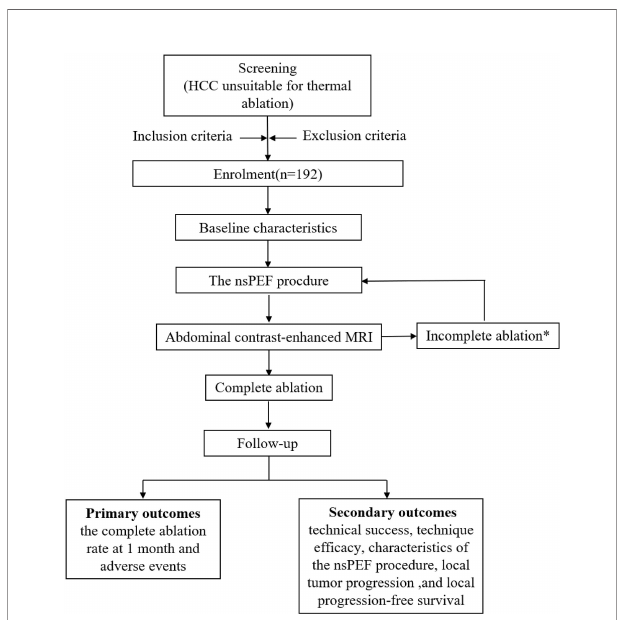
FIGURE 2 | Flow chart of study. *Contrast-enhanced MRI will be performed 1 month after the procedures to evaluate technique ef fi cacy. In the event of incomplete ablation, an additional nsPEF procedure will be conducted with the same technique. If the residual tumor is still viable after the second session, then nsPEF is considered failed, and the patient will be excluded from the trial and referred to other therapies. HCC, hepatocellular carcinoma; nsPEF, nanosecond pulsed electric fi eld; MRI, magnetic resonance